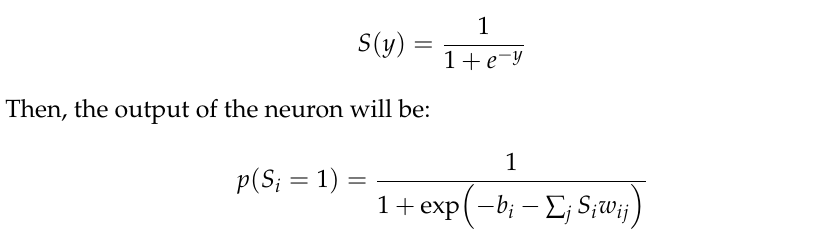
Figure 16. ( a ) Graphical description of restricted Boltzmann machine (RBM) with n visible and m hidden units; ( b ) deep belief network (DBN) adopted in the present study with four hidden layers, eight input neurons, and one output neuron.